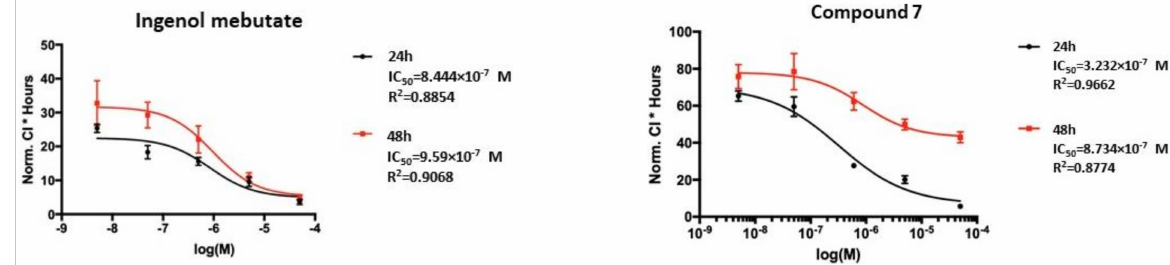
Figure 4. Real-time cell analysis (RTCA) measurement of CI (cell index) values of HPV-Ker cells treated with ingenol mebutate and compound 7 . Normalized CI * hours values were plotted as a function of concentration of the indicated diterpenoid